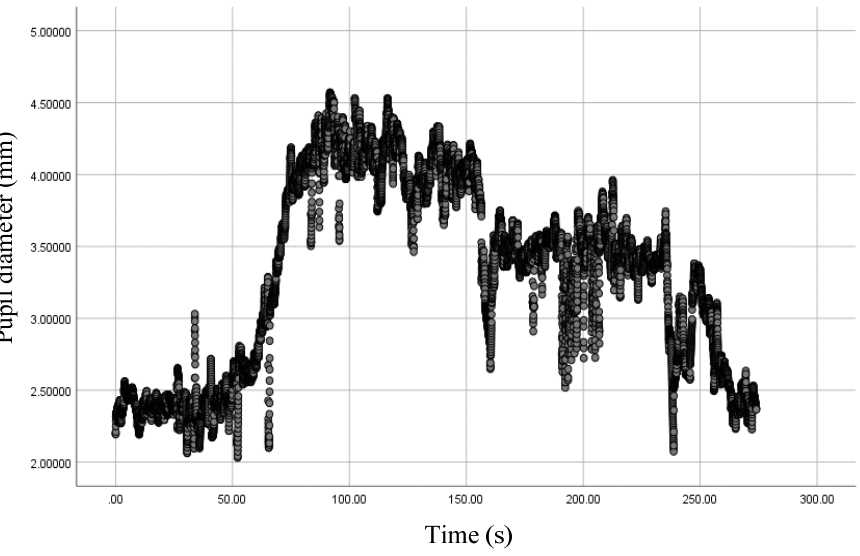
Figure 2. Driver pupil diameter change curve.